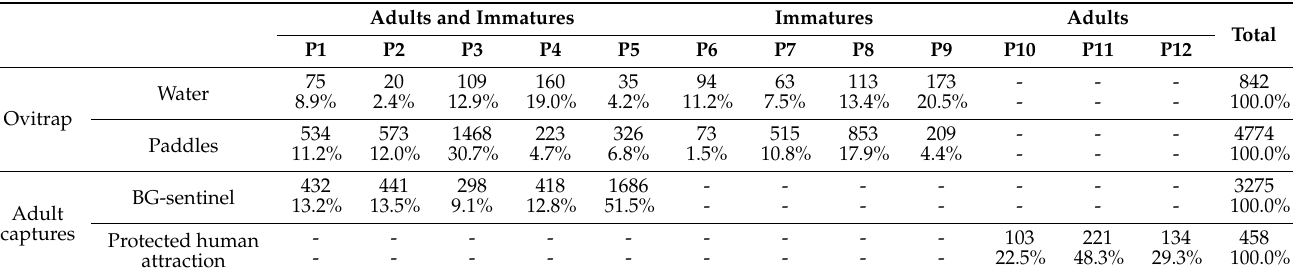
Table 3. Absolute numbers and percentages of specimens collected at nine sampling sites at the Centro de Primatologia do Rio de Janeiro according to the type of collection from December 2018 to December 2019. Adults and Immatures Immatures